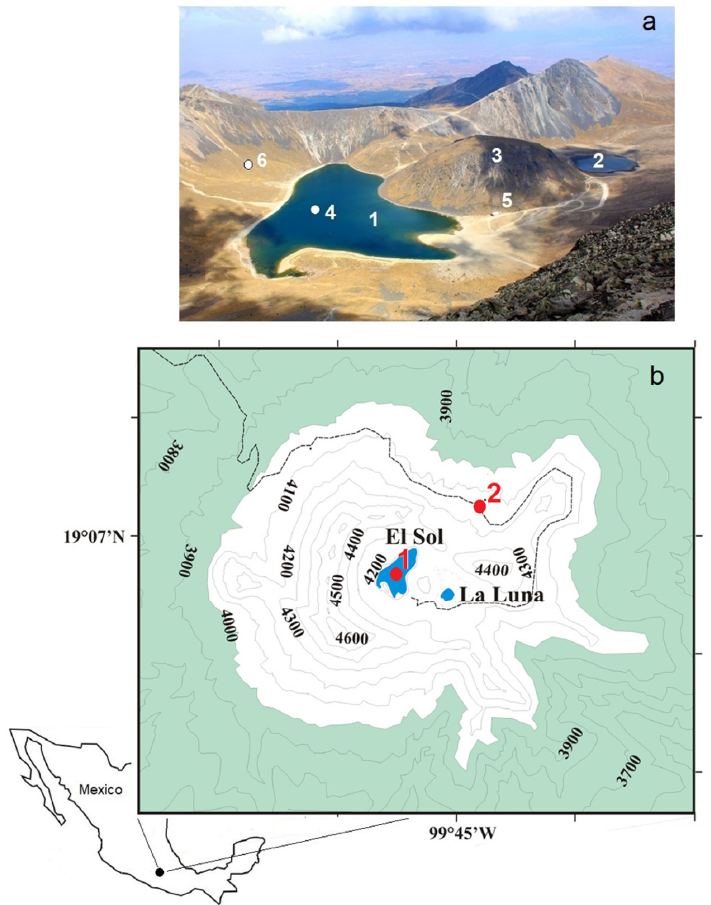
Figure 1. ( a ) Geographical location of the Nevado de Toluca volcano and Lakes El Sol and La Luna. Photograph of the volcano crater is available in [36]. The numbers indicate: 1—Lake El Sol, 2—Lake La Luna, 3—Lava dome, 4—the position of the floating weather station, 5—the position of the meteorological station installed on the shore in 2007–2010, 6—location of the Hobo V-2 ther- mograph on the western slope of the crater. (2). ( b ) A topographical chart of the volcano. The red dots indicate the location of the floating weather station in Lake El Sol (1), and the location of the SMN weather station on the outer slope. Volcano diagram adapted from [29]. station on the outer slope. Volcano diagram adapted from